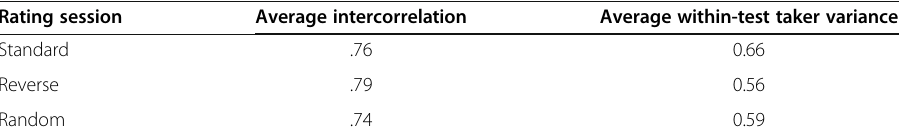
Table 10 Conventional halo indices of novice ratings Rating session Average intercorrelation Average within-test taker variance Standard .76 0.66 Reverse .79 0.56 Random .74